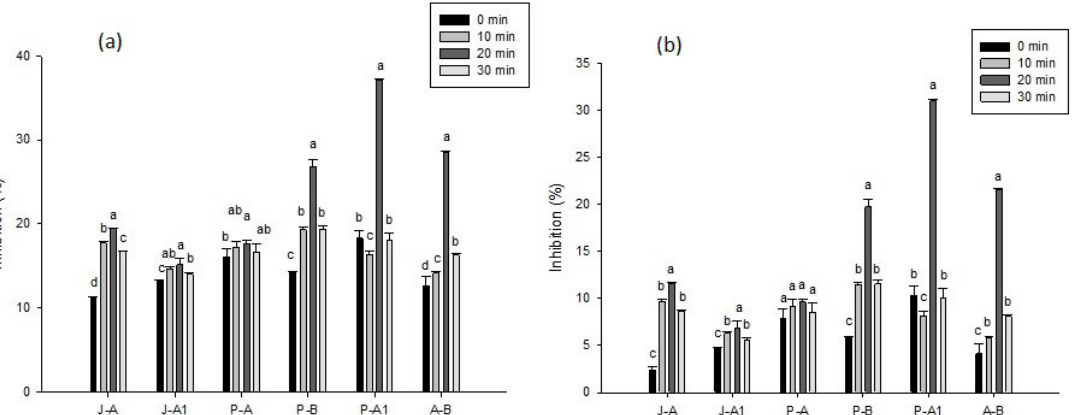
Figure 3. Effects of different ultrasound times (0, 10, 20, 30 min) on the bioactive compounds of different honeys: ( a ) α -amylase and ( b ) α -glucosidase. The results are expressed as means ± standard deviation. Different letters represent significant differences ( p < 0.05) between